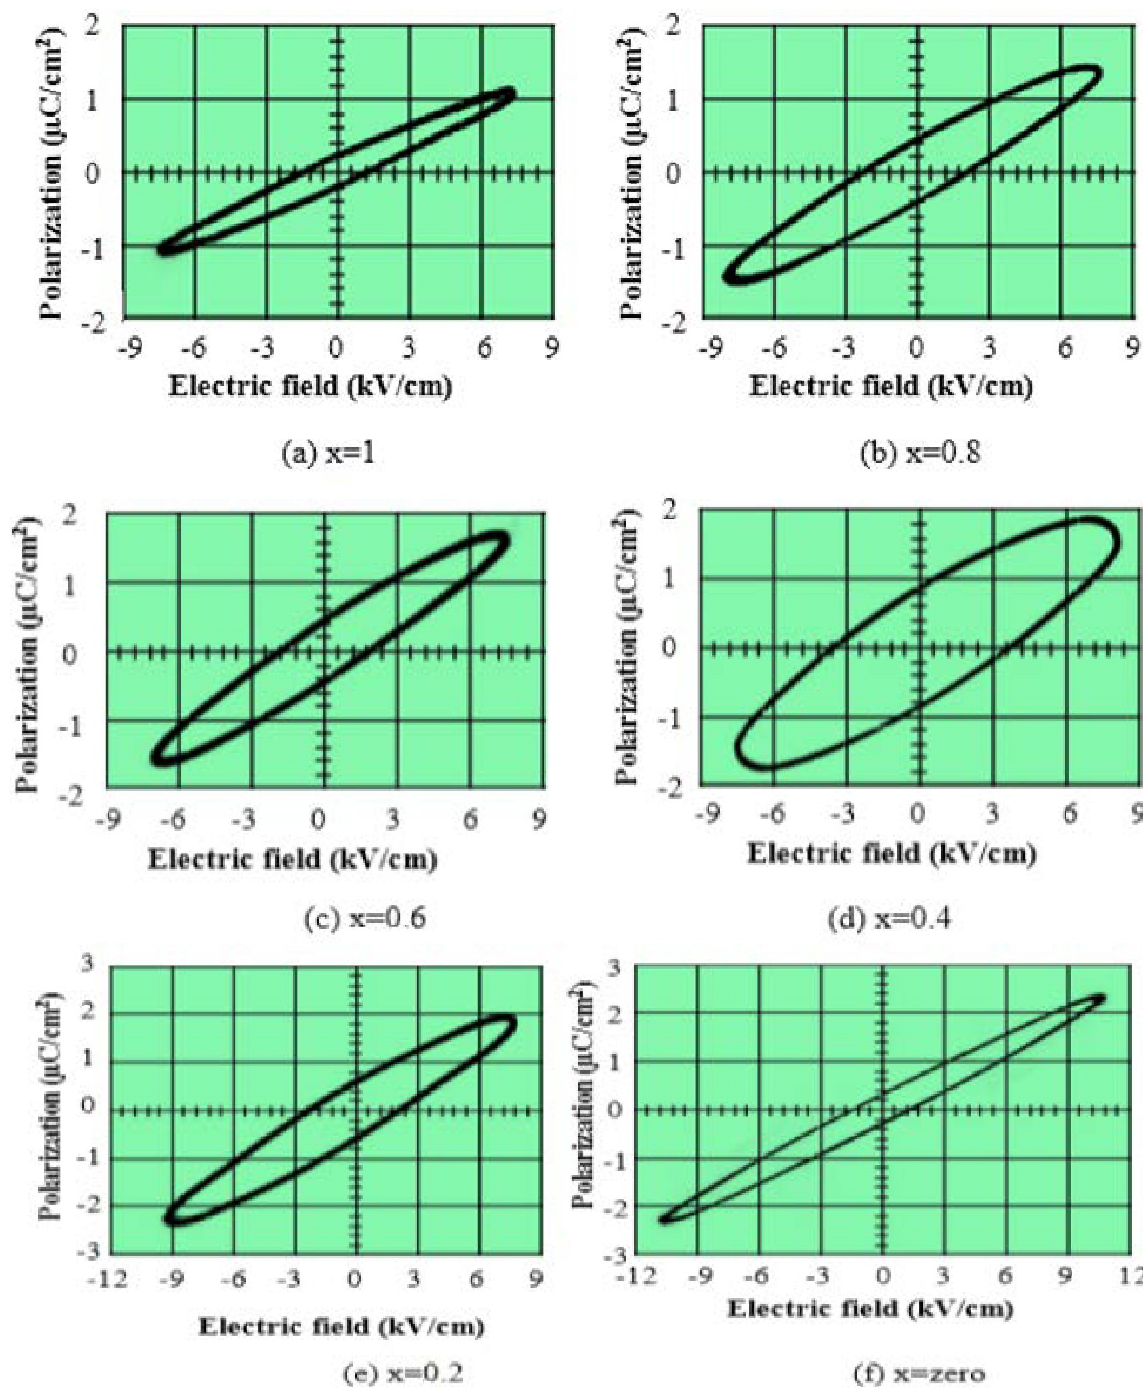
Figure 9. ( a - f ): The dielectric hysteresis loop of the composite samples.